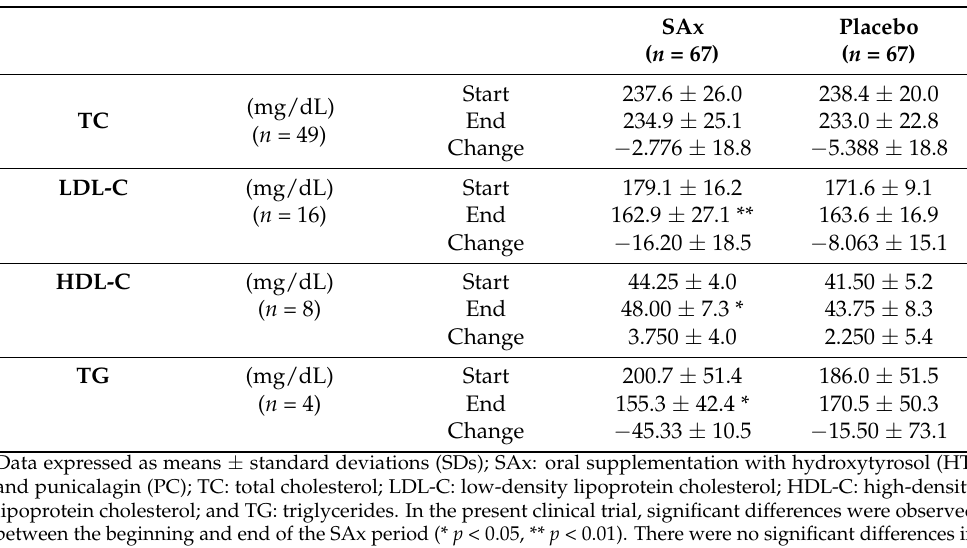
levels of HDL-C was observed in subjects with initially low plasma levels of HDL-C (SAx period start: 44.25 ± 3.99; end: 48.00 ± 7.27 mg/dL; p < 0.033). After the placebo period, this significant effect on plasma HDL-C levels was not observed in these subjects (Placebo period start: 41.50 ± 5.19; end: 43.75 ± 8.26 mg/dL; p < 0.464) (Figure 3). In the present clinical trial, only women showed low plasma levels of HDL-C. There were no men who presented low plasma levels of HDL-C.